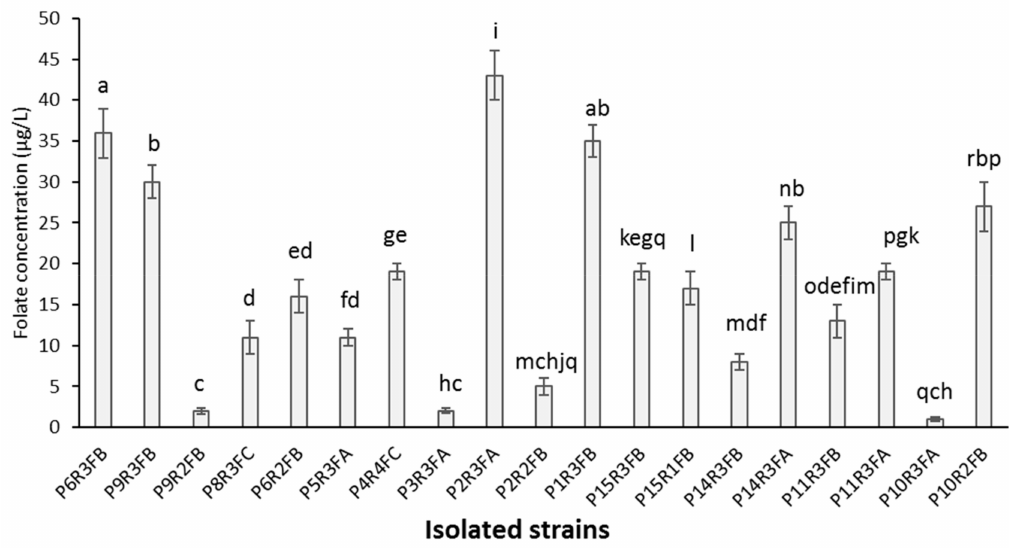
Figure 3. Production of folate by 19 LAB isolated from tef dough when incubated at 30 ◦ C for 24 h in Folic Acid Casei Medium (FACM). Bars indicate standard deviations among analytical replicates. Mean values with di ff erent superscript letters indicate a statistically significant di ff erence between experimental groups ( p <